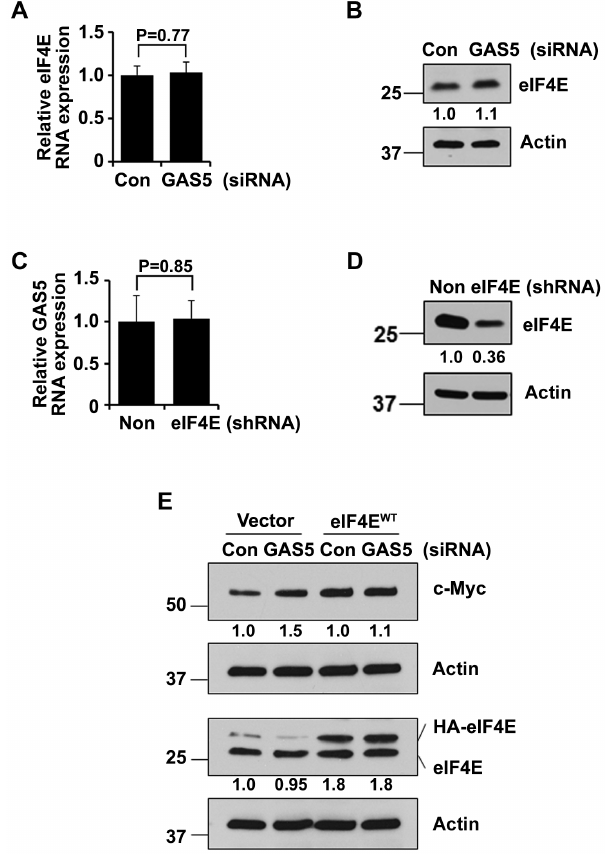
Figure 5. GAS5 cooperates with eIF4E to regulate c-Myc translation. ( A-B ) eIF4E expression at mRNA ( A ) and protein level ( B ) was assessed by Q-PCR and western blot after the cells were treated with GAS5 or control siRNA. Bars represent mean 6 SD from 3 replicates. The experiment was performed three times. ( C ) GAS5 expression was quantified by Q-PCR in the HEK-293T cells transfected with non- silencing or eIF4E shRNA. Bars represent mean 6 SD from 3 replicates. ( D ). eIF4E protein level after the cells were stably transfected with non- silencing or eIF4E shRNA. ( E ) The protein level of c-Myc and eIF4E was assessed after the cells were transfected with GAS5/control siRNA and